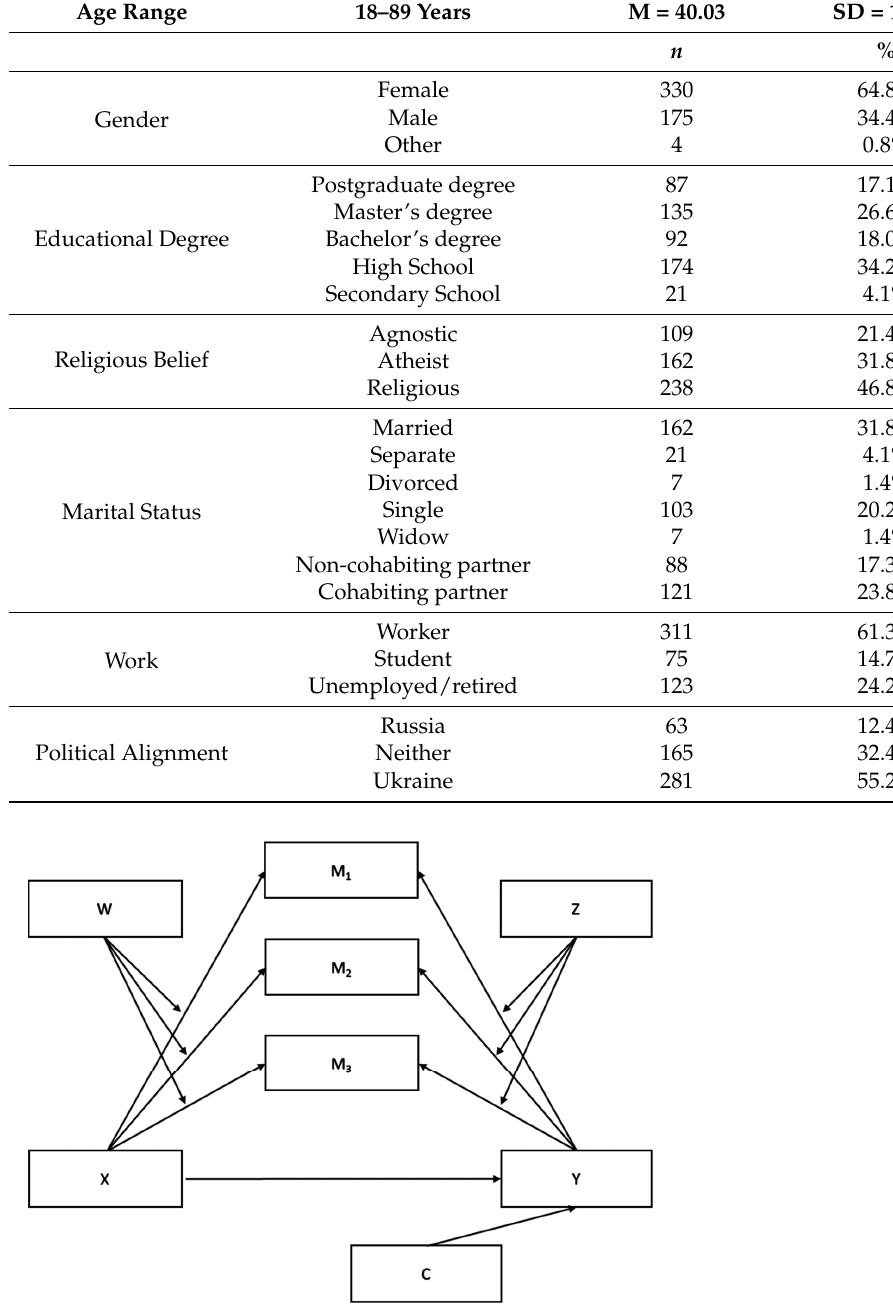
Figure 1. Proposed multiple moderated mediation model (Model 21). Note. X, independent variable; Y, dependent variable; M1, mediator 1; M2, mediator 2; M3, mediator 3; W, moderator 1; Z, moderator 2; C = covariate.